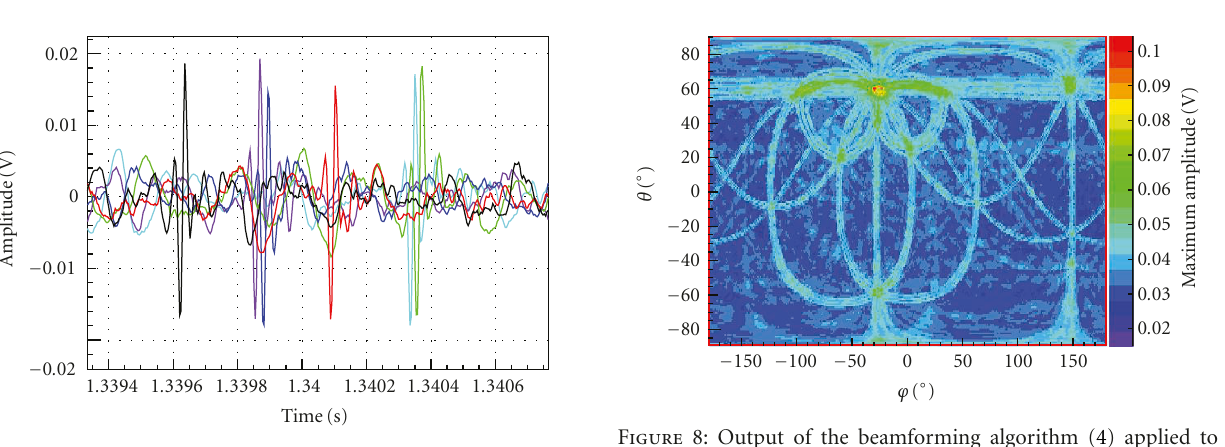
Figure 8: Output of the beamforming algorithm (4) applied to the signal shown in Figure 7. The maximum, indicating the signal direction, can be identified at θ = 59 ◦ and ϕ = − 29 ◦